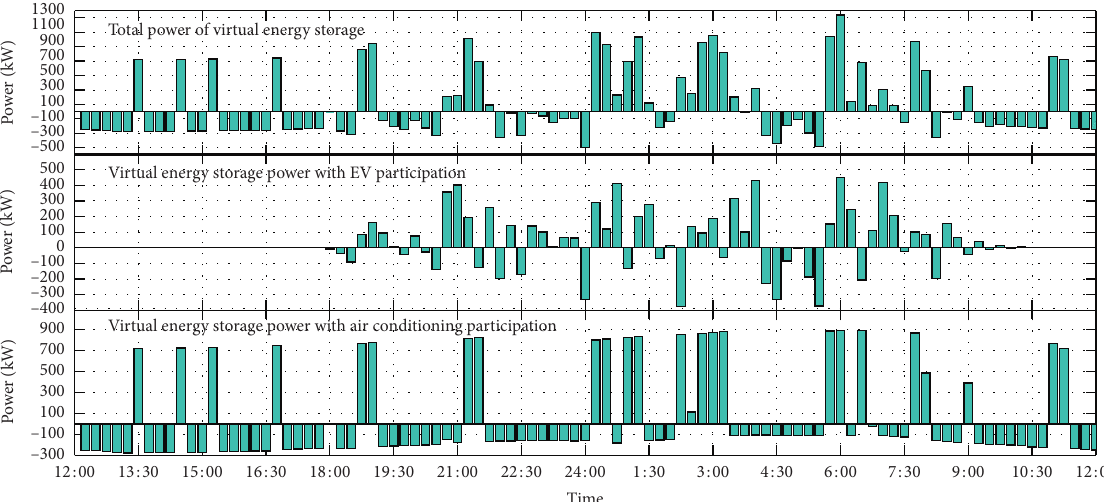
Figure 19: Optimized power of combined virtual energy storage in